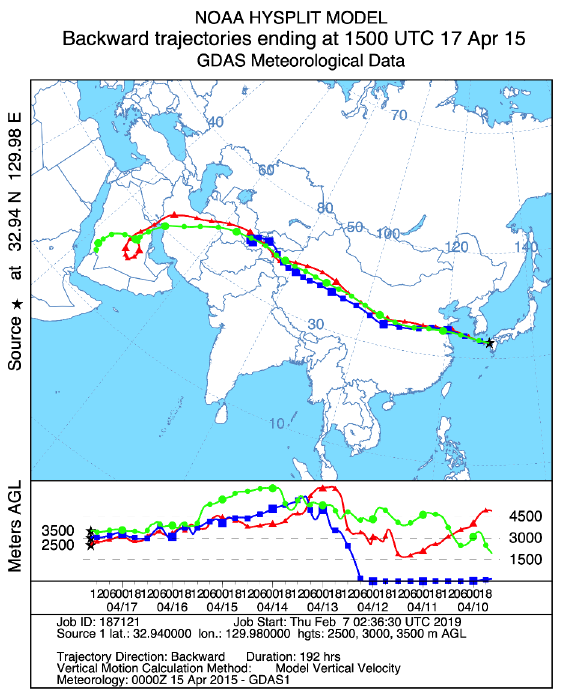
Fig.5 HYSPLIT backward trajectory of the dust observed in Nagasaki on April 17,